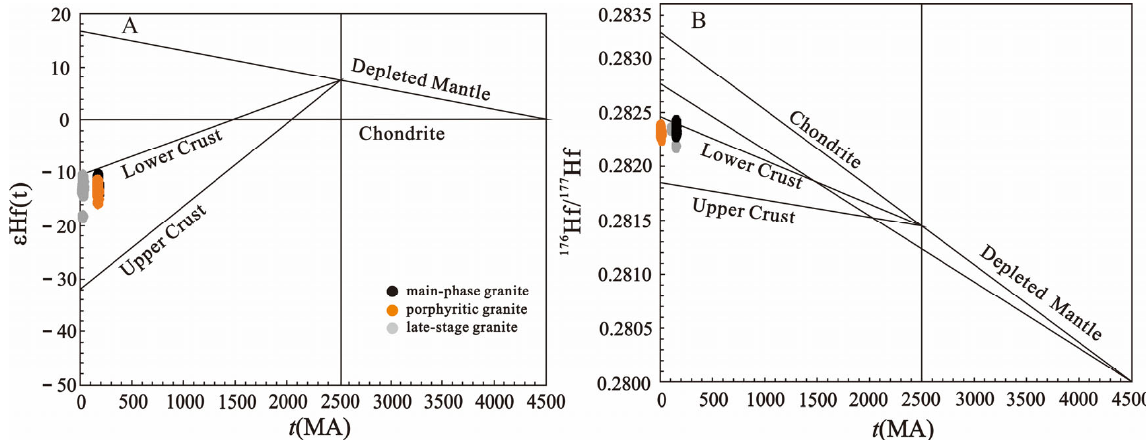
Figure 9. ε Hf(t) vs. age plots ( A ) and 176 Hf/ 177 Hf vs. age plots ( B ) for the Jinzhuping zircons.